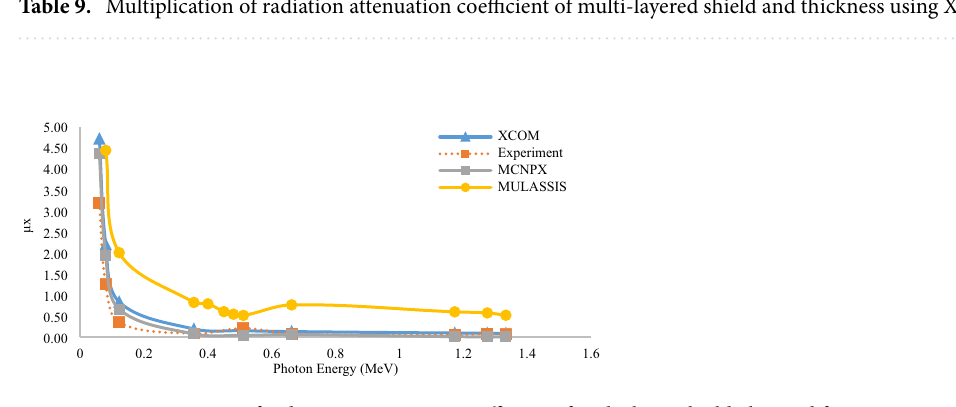
Table 9. Multiplication of radiation attenuation coefficient of multi-layered shield and thickness using XCOM.